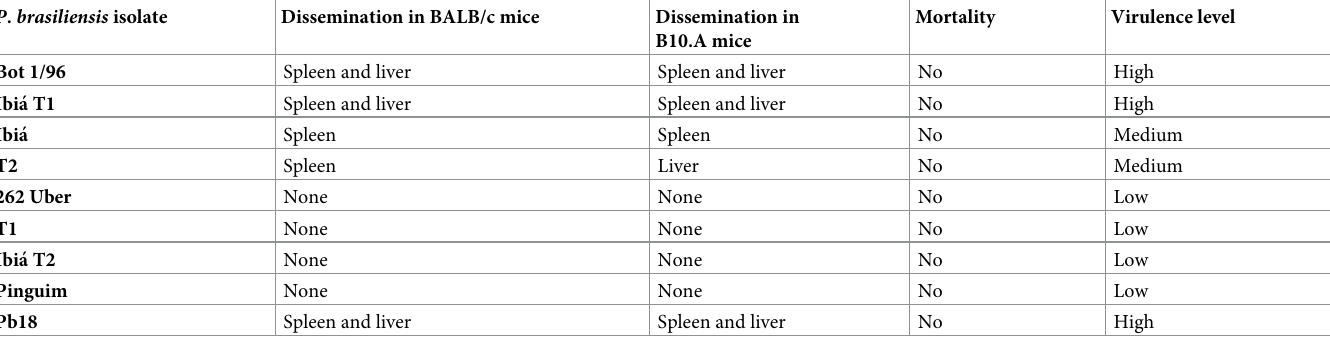
Table 2. Virulence characteristics of P . brasiliensis complex isolates based on murine model of infection. P . brasiliensis